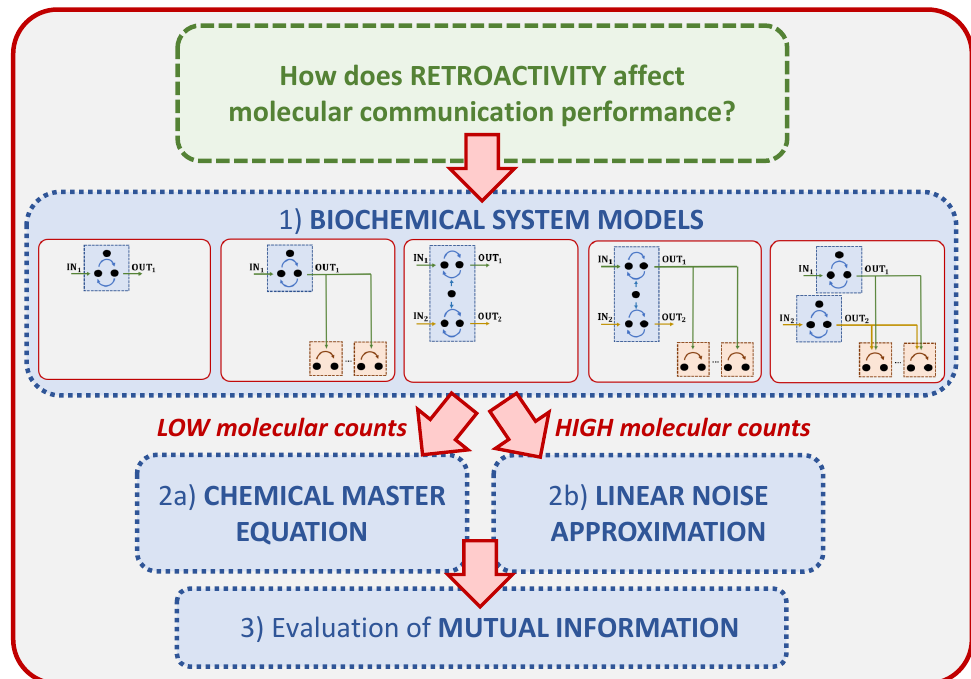
Figure 1. Overview of the structure of the paper. The biochemical system models are detailed later in Figure 3. The Chemical Master Equation (CME) is a system of differential equations that describes the rate of change of the probability of the system to be in any give state at time 𝑡 [47]. The Linear Noise Approximation (LNA) of the CME is a linear time-varying stochastic differential equation that allows a stochastic characterization of the evolution of a chemical reaction network, still maintaining scalability comparable to that of the deterministic models